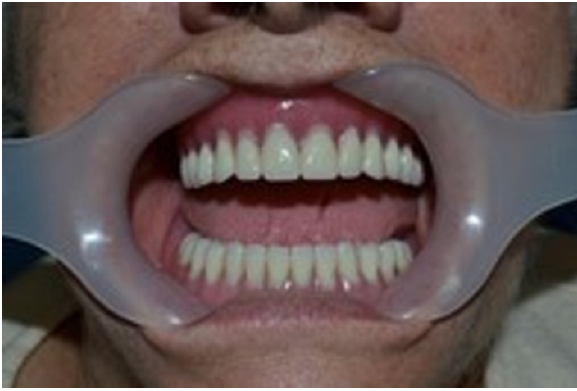
Figure 12. Final dentures in the oral cavity.